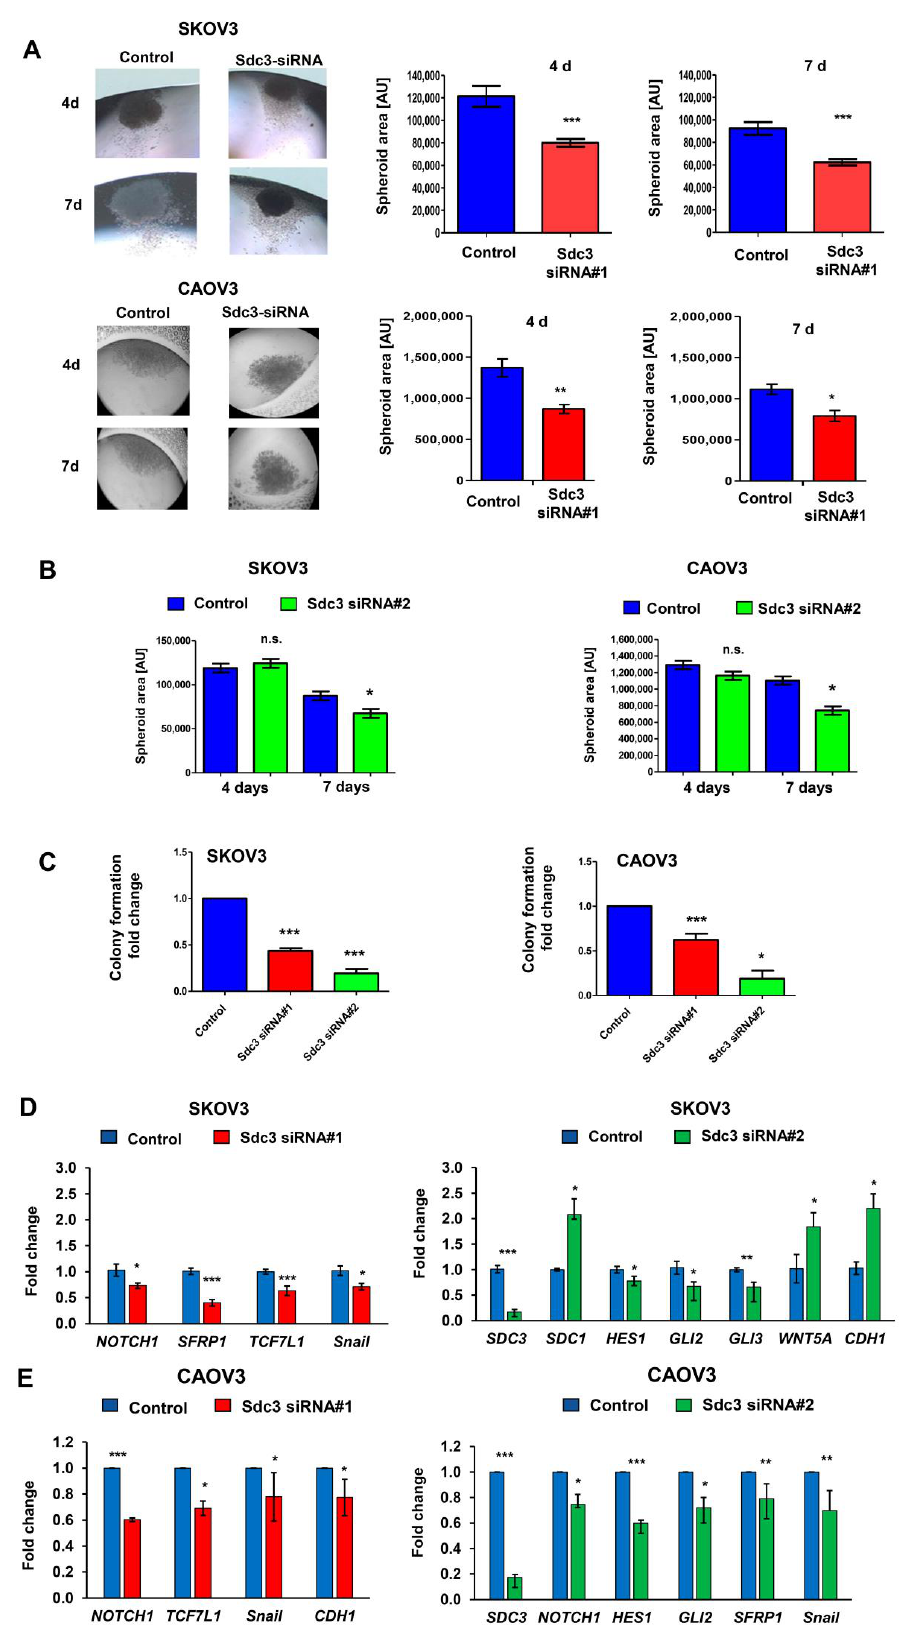
Figure 2. SDC3 depletion reduces the size of 3D SKOV3 spheroids and alters stemness-related gene expression. ( A ) Control siRNA and SDC3-siRNA#1- and #2-treated SKOV3 and CAOV3 cells